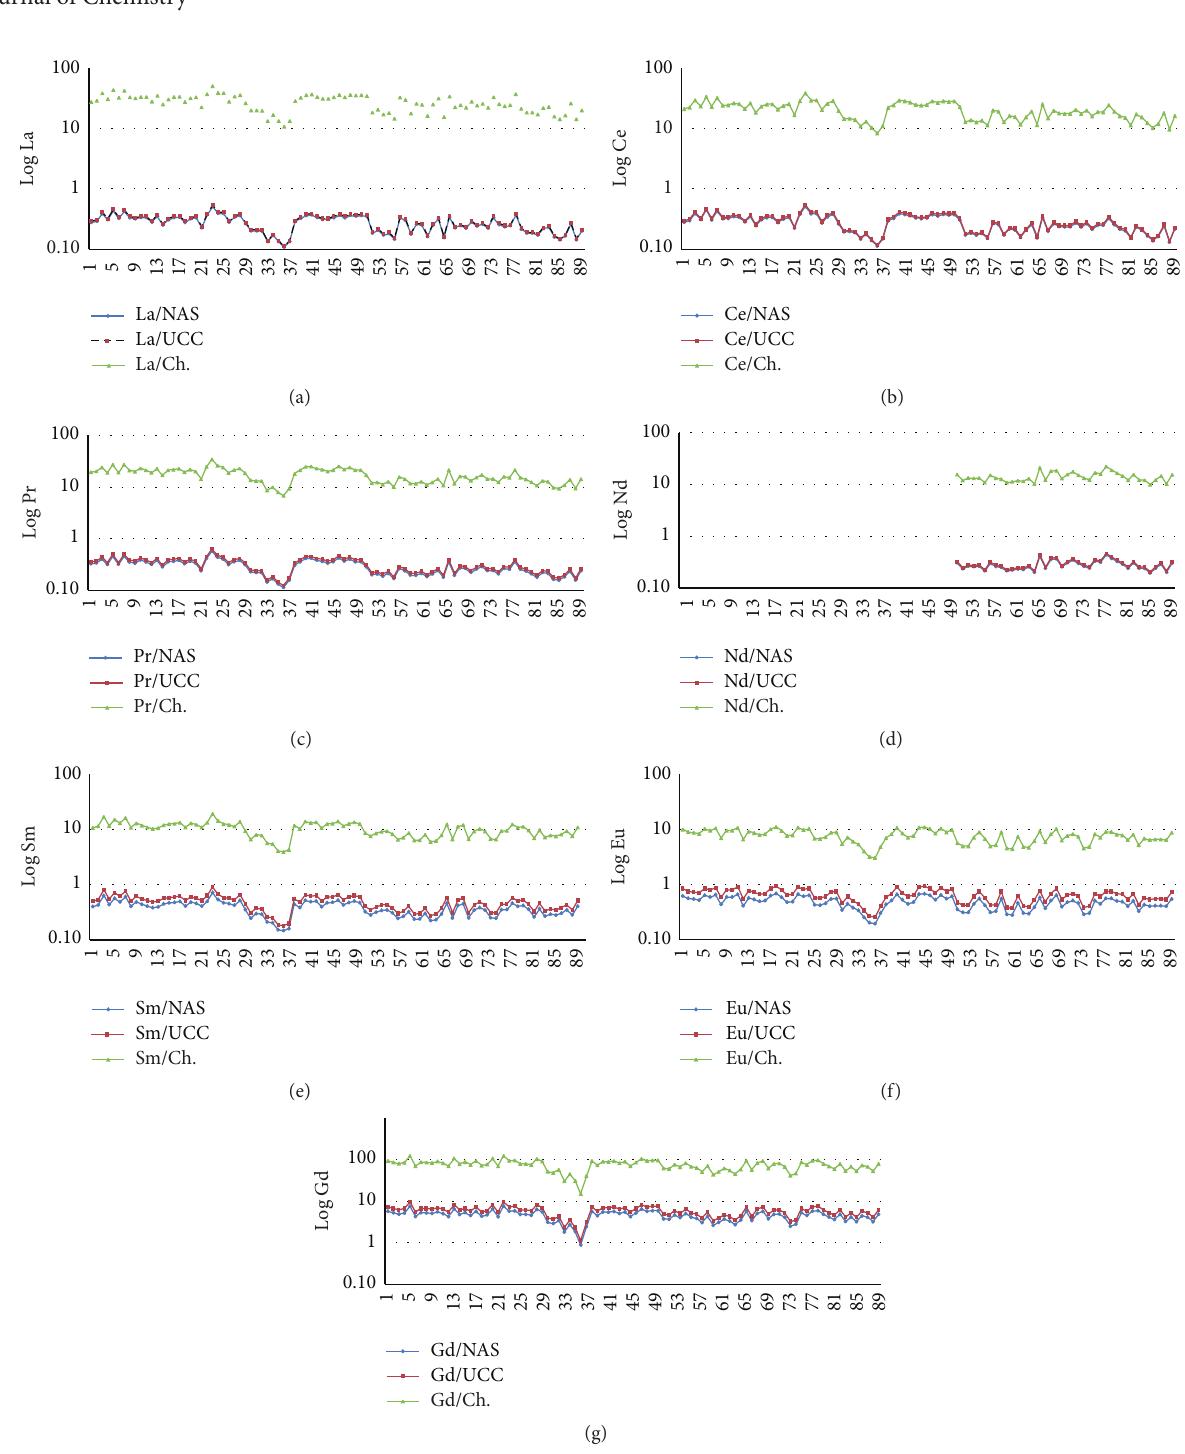
are lower by 8.33 to 3.63 and 39.52 to 18.34 times compared to the REE compositions of the Mississippi River and Amazon River REE compositions. The researchers indicated that the light and middle REE enrichment in river sediments may